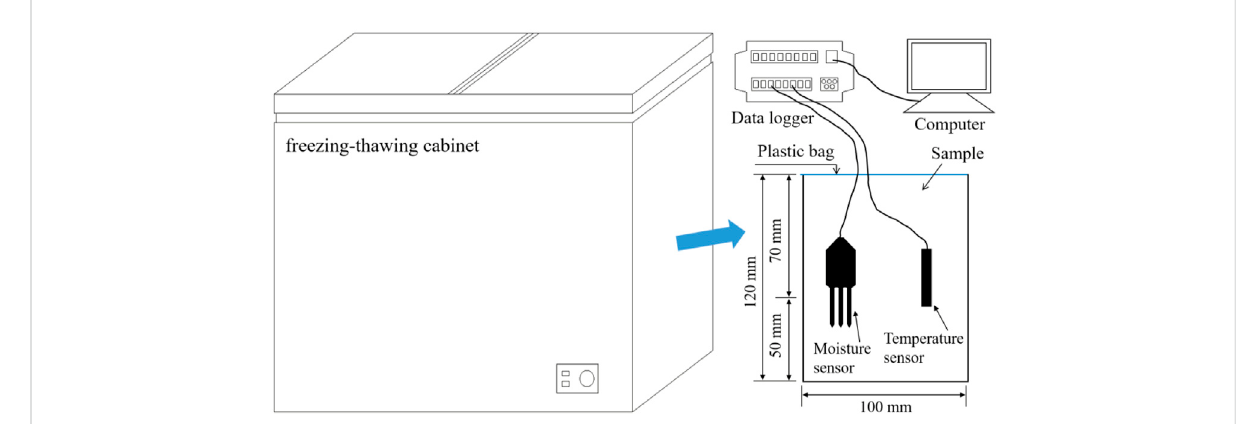
FIGURE 1 Experimental apparatus for freezing-thawing